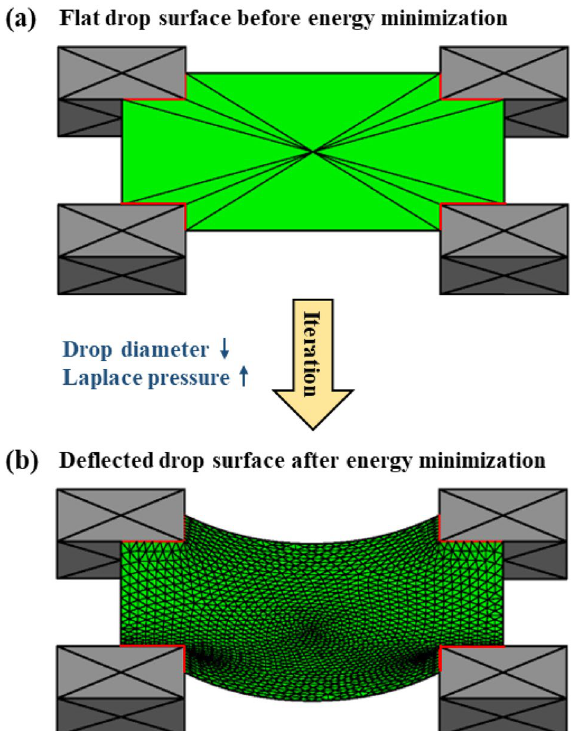
Figure 7. ( a ) Planar liquid surface in the SE model on a unit cell and ( b ) the deflected surface after energy